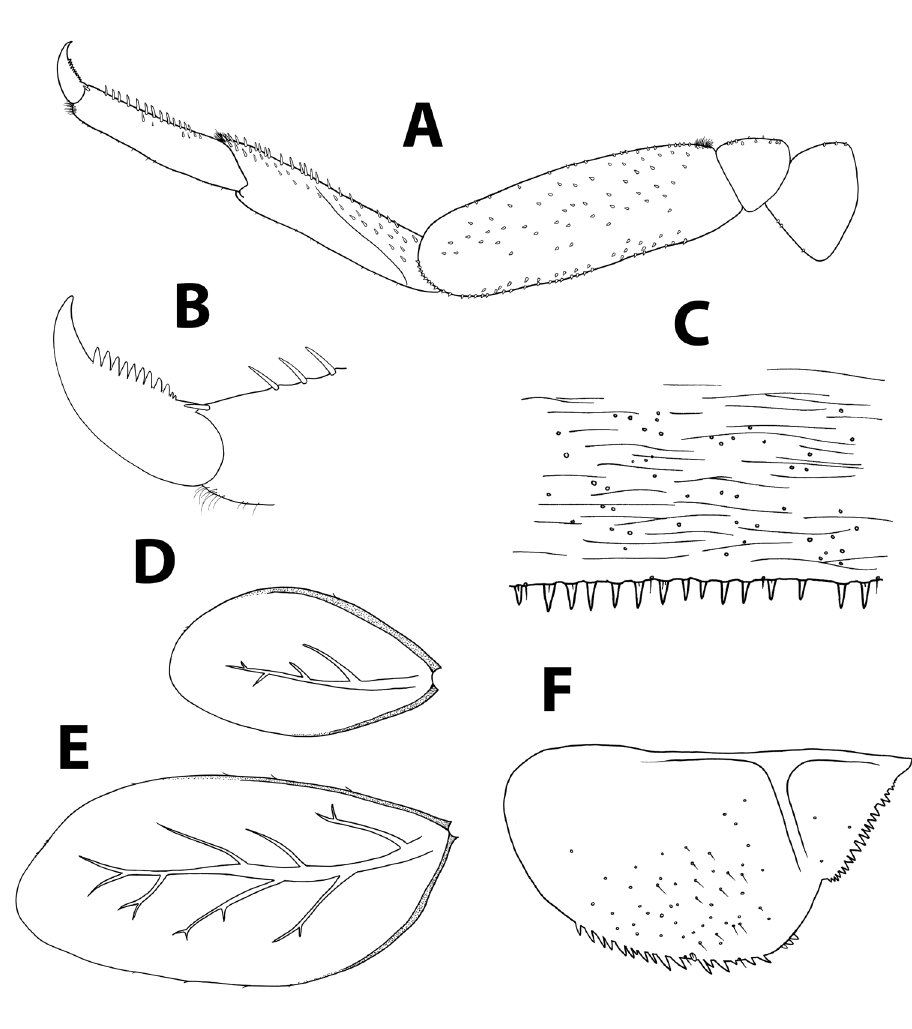
Figure 17. Baetis samochai , nymph. A foreleg B tarsal claw C abdominal tergum V, surface and distal margin D gill I E gill IV F paraproct